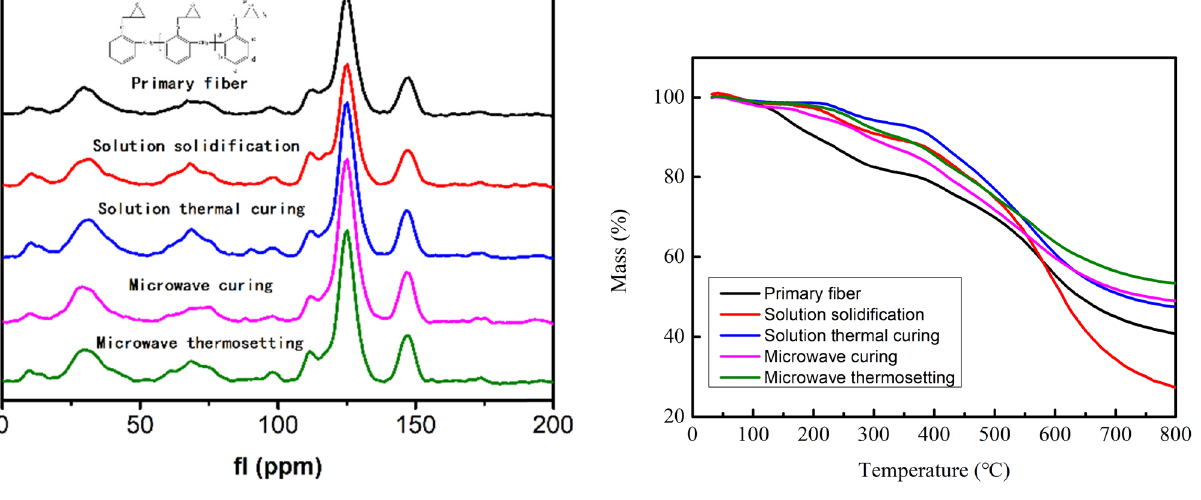
Figure 5: The 13 C NMR of epoxy - modi fi ed phenolic fi bers. Figure 6: TGA diagram of di ff erent fi bers in N 2